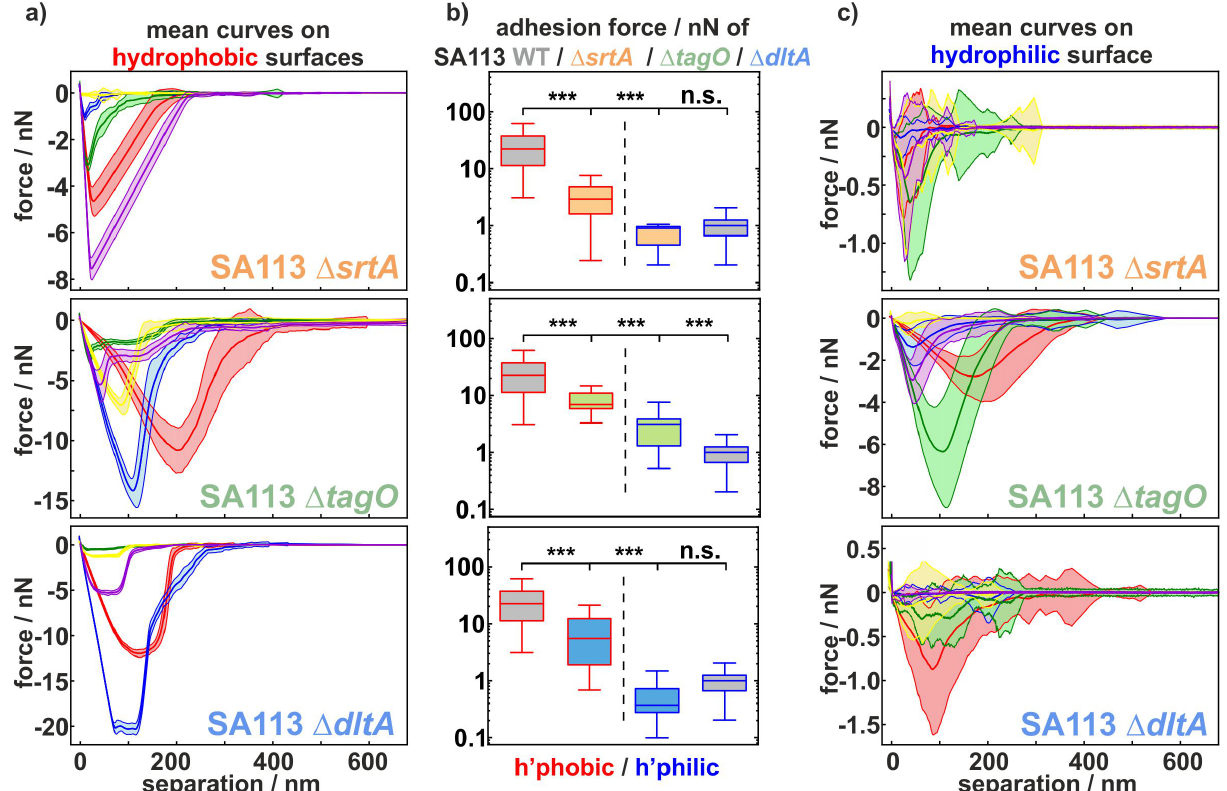
Figure 1. Adhesive strength of SA113 knock-out mutants to hydrophobic and hydrophilic surfaces. ( a , c ) For five individual mutant cells of each type, represented by five different colours, mean retraction parts of over 50 measured force–distance curves (with standard error as the shaded area) on both surfaces are shown. ( b ) In addition, box and whisker plots (min-to-max) of the adhesion force on hydrophobic and hydrophilic surfaces are shown for all tested mutant cells compared with the SA113 wild-type (WT) cells [28] (gray) in a logarithmic scale. Comparison between data sets was performed by ordinary one-way ANOVA and Dunnett’s test for multiple comparison as well as an unpaired t-test for the pairwise comparison between the adhesion of the mutants to hydrophobic and hydrophilic surfaces: n.s., p > 0.05; ***, p <